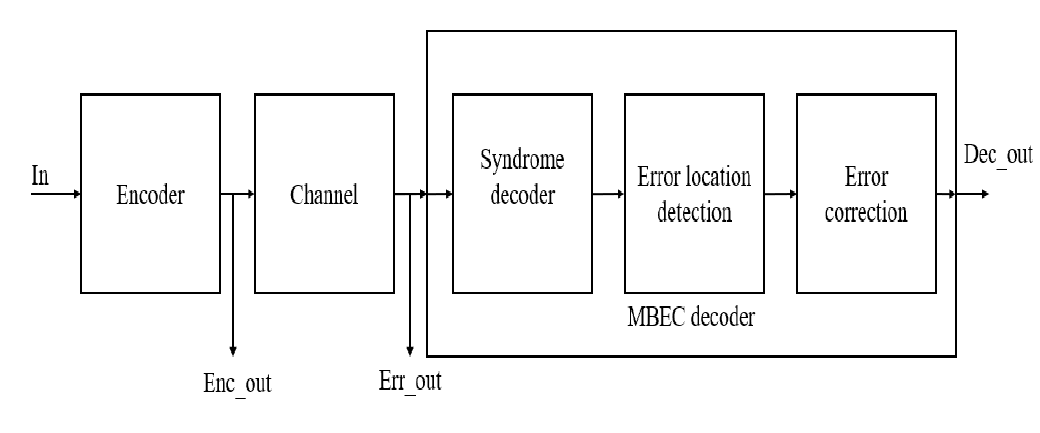
Figure 1.Proposed MBE-DCC flowchart